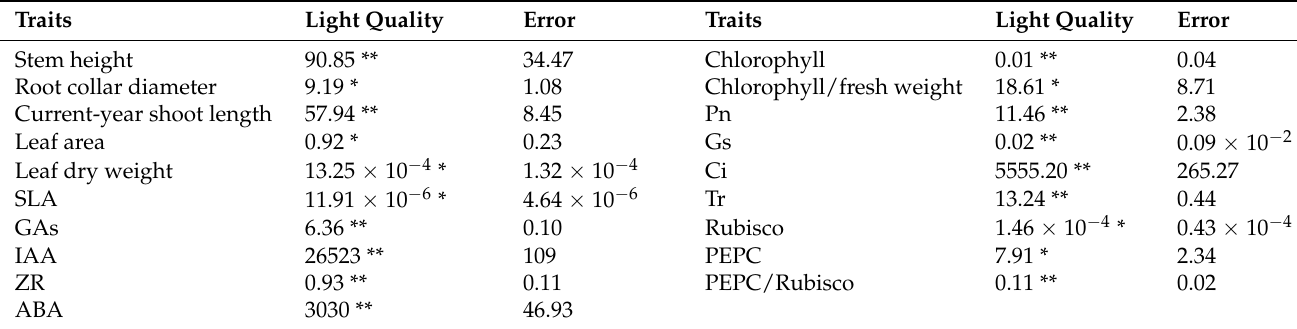
Table 2. Summary of ANOVA results comparing Norway spruce morphological and physiological parameters among the four light